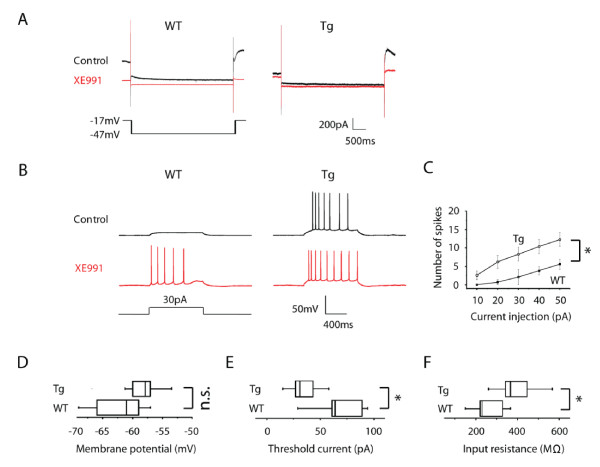
Electrophysiological characterization of CA1 pyramidal neurons from wild type and transgenic mice. A. Representative deactivation currents recorded from CA1 pyramidal neurons in fresh slice preparations from wild type (WT, left panel) or transgenic mice (Tg, right panel). Overlay of currents evoked by the protocol in the absence (black) or presence (red) of 10uM XE991. B. Response of CA1 pyramidal neurons with injection of 1000ms, 30pA depolarizing current pulse into the cell from WT (left panels) and Tg mice (right panels) before (black) and after (red) application of XE991. XE991 increased action potential firing in WT mice, but it was less effective in neurons from Tg mice. C. Comparison of average number of spikes evoked by injected current in WT and Tg neurons. D-F. Box plots illustrating the differences in WT and Tg mice in resting membrane potential, threshold current required for action potential firing and input resistance, n = 10; Data are shown as mean ± s.e.m., *p < 0.05.